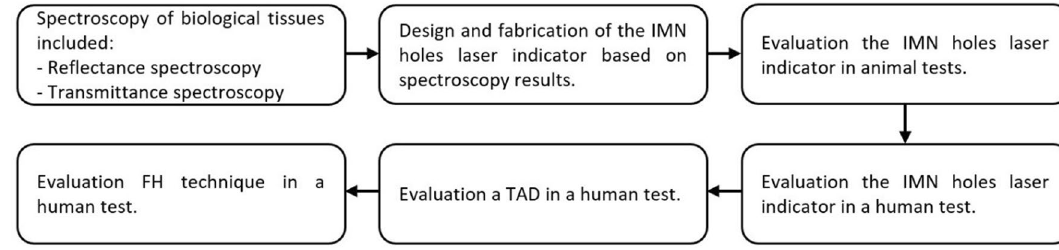
Figure 1. Flow diagram depicting the study selection procedure.